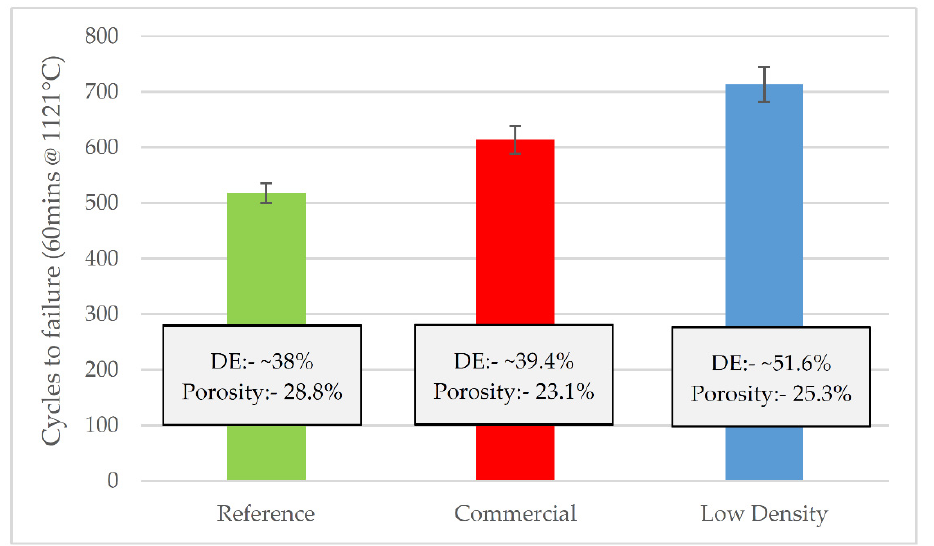
Figure 7. Furnace Cyclic fatigue lifetime results.